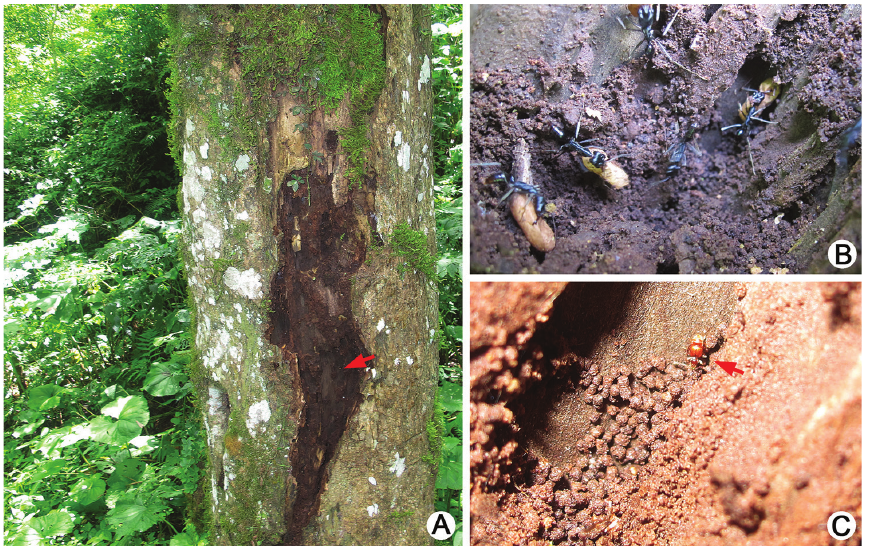
Figure 12. Habitat of Batrisodes grossus . A Colony of host ant under bark B A closer view of ant colony C A living Batrisodes grossus walking inside the nest.